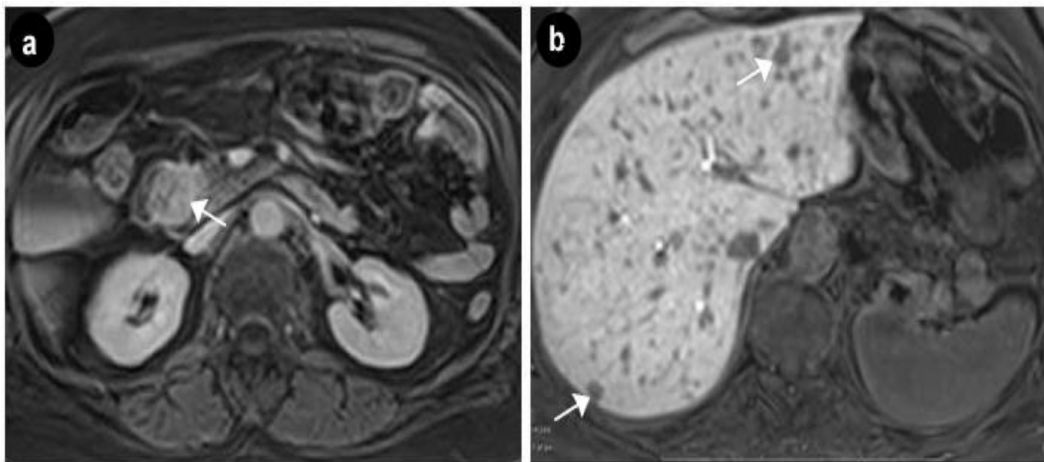
Figure 12. Follow up MRI at 3 months. ( a ) Slight regression of the duodenal tumor on T1w image after gadolinium enhancement (arrow). ( b ) Minimal regression of the metastatic hepatic lesions on the hepato-biliary phase (arrows).